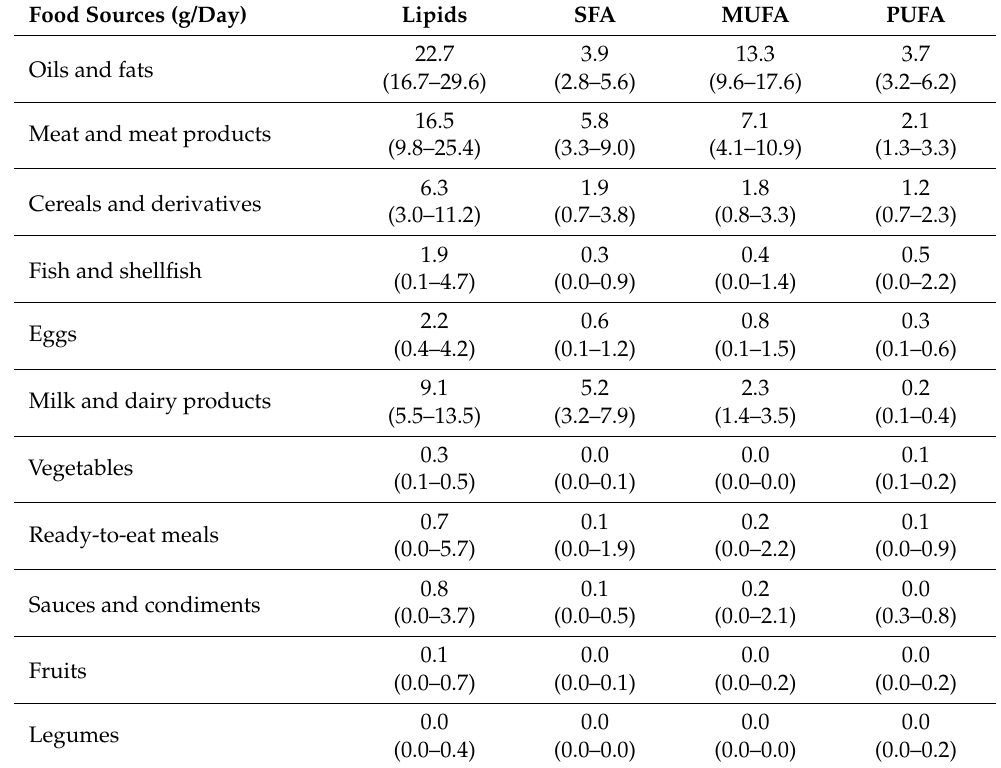
Table 11. Contribution of dietary food sources to lipid intakes among the ANIBES Study